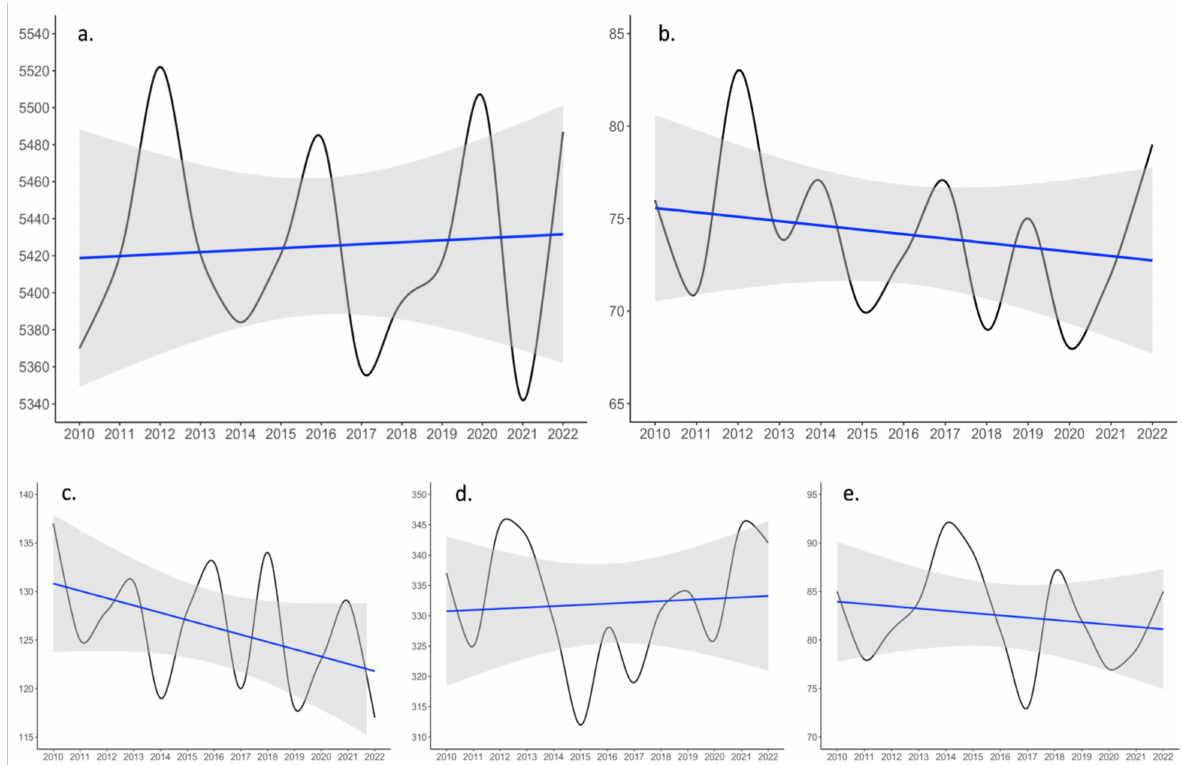
Figure 4. Population fluctuations and trends of the two native terrapins on the island of Lesvos: ( a ) M. rivulata, ( b ) E. orbicularis , ( c ) M. rivulata in the Vouvaris river, ( d ) M. rivulata in the Skala Eresou river, and ( e ) M. rivulata in the Skalochori pond; The blue line indicates the popula- tion trend based on the Poisson distribution and the shaded area represents the confidence intervals. In all cases, the native terrapin populations have remained stable throughout the years. It is worth mentioning that there was no E. orbicularis in the Vouvaris river, nor in the Skala Eresou river. In the Skalochori pond, there was one individual which we observed during the 2019 and later